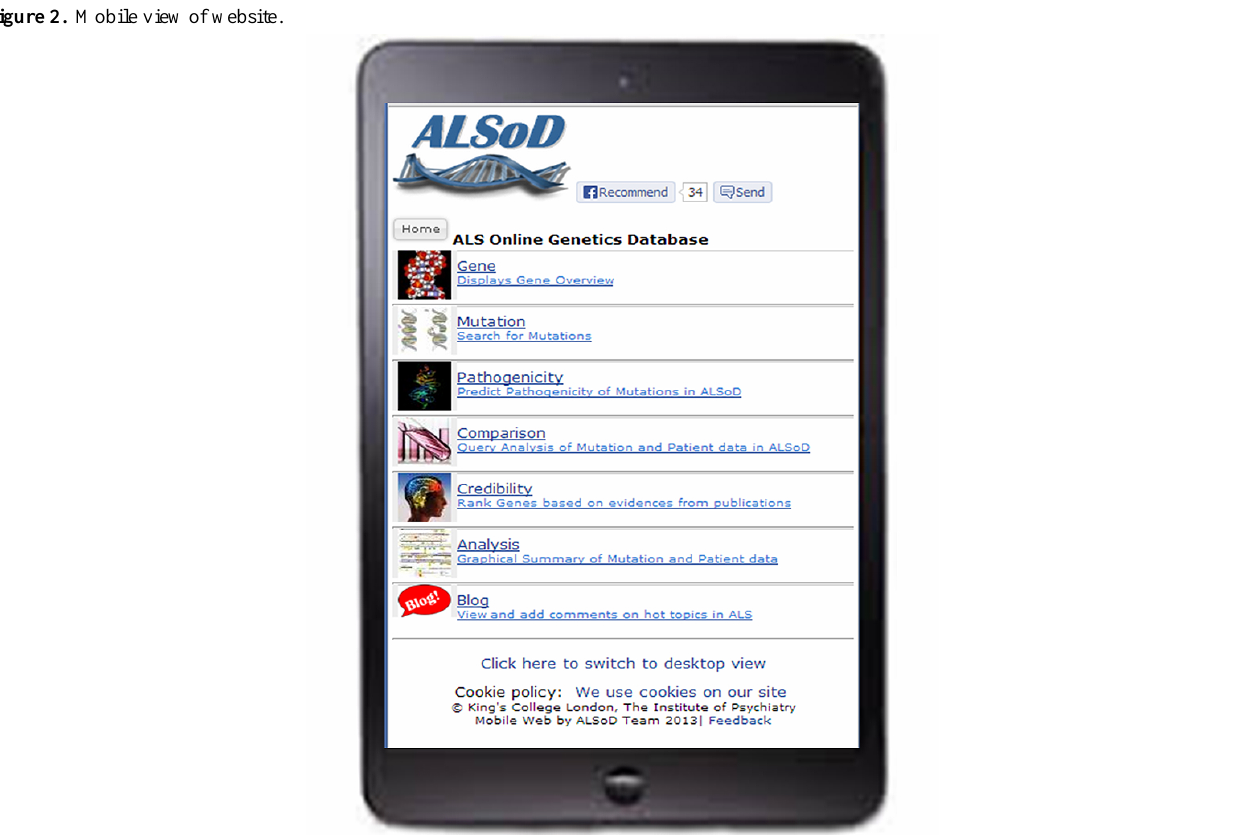
Figure 2. Mobile view of